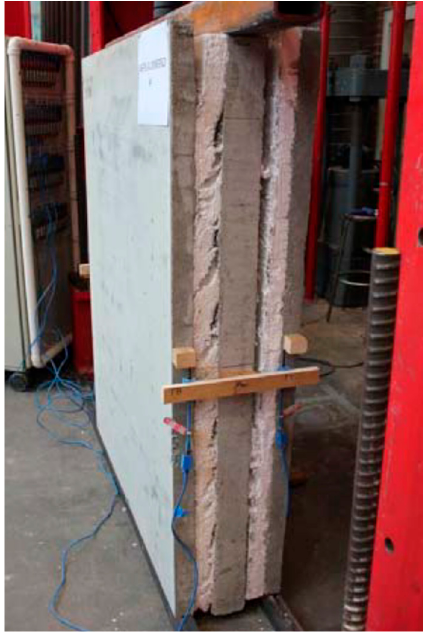
Figure 18. View of a typical failure mode showing shear between wythes.